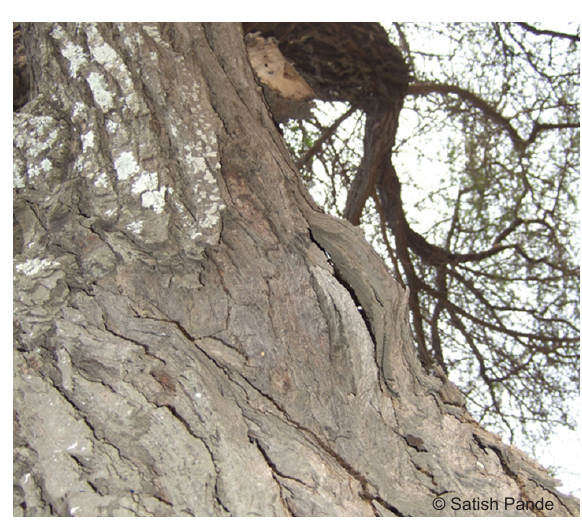
Image 6. Under the tree